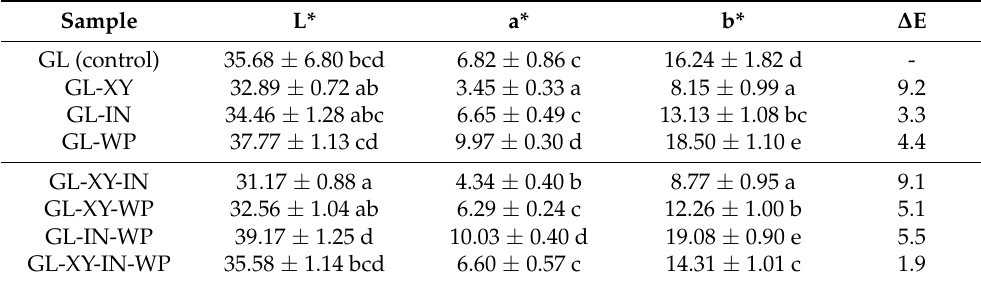
Table 4. Color parameters of green lentil cookies.